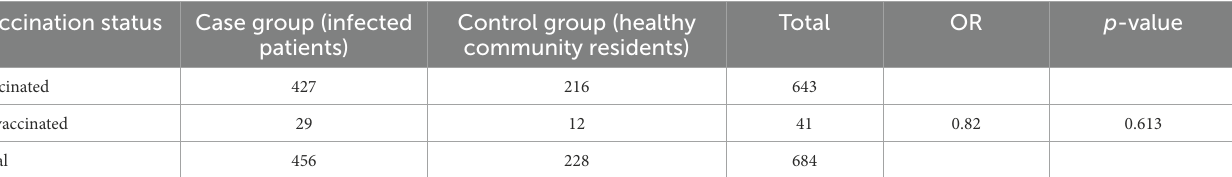
TABLE 2 Distribution of vaccination status for both cases and controls.